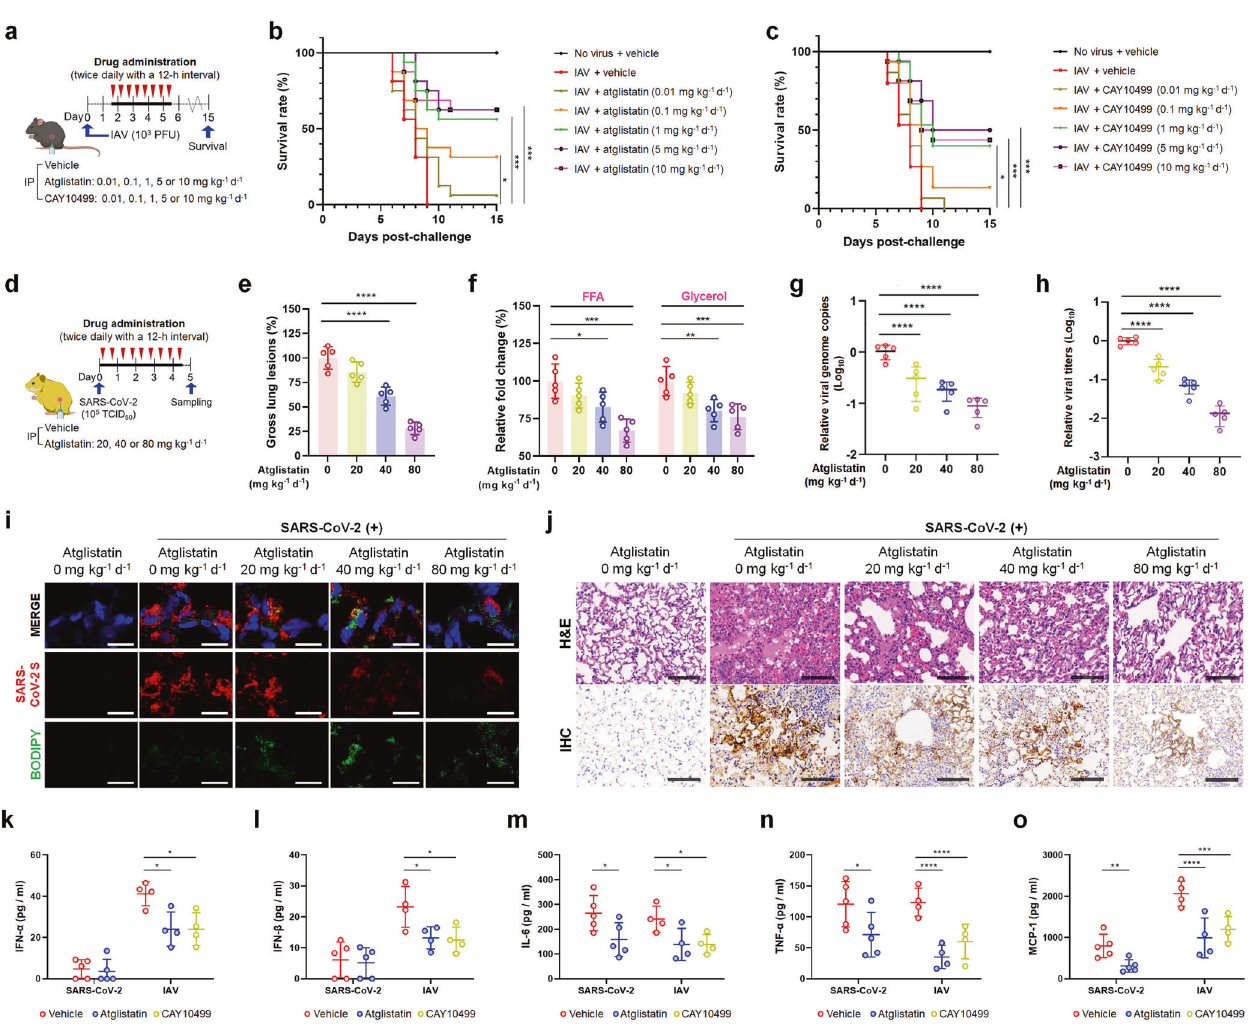
Fig. 5 In vivo antiviral and anti-proin fl ammatory cytokine effects of lipase inhibitors against in fl uenza A virus (IAV) and SARS-CoV-2. a Scheme of chemical administration twice daily for 4 consecutive days after challenge with 10 3 PFU of mouse-adapted IAV PR8 strain to mice ( n = 16). b , c Survival rates (expressed as percentages) of IAV-challenged mice by treatment with either atglistatin ( b ) or CAY10499 ( c ). d Scheme of chemical administration twice daily for 4.5 consecutive days after challenge with 10 5 TCID 50 of SARS-CoV-2 KCDC03 strain to Syrian hamsters ( n = 5). e Reduction in SARS-CoV-2-induced gross lung lesions in hamsters by treatment with atglistatin. f In vivo inhibition of FFA and glycerol release from LDs in lungs sampled from SARS-CoV-2-challenged hamsters ( n = 5) by treatment with atglistatin. g , h Reduction in SARS-CoV-2 genome copy number and infectious progeny production in lungs sampled from SARS-CoV-2-challenged hamsters ( n = 5) by treatment with atglistatin. i Representative images of LDs and virus replication. Retention of LDs (green, lower panels) and inhibition of SARS-CoV-2 replication (red, middle panels) in alveolar epithelial cells of lung tissues sampled from SARS-CoV-2-challenged hamsters by treatment with atglistatin. j Representative images of histological lung lesions. Amelioration of histological lung lesions (upper panels) and inhibition of SARS- CoV-2 replication (lower panels) by treatment with atglistatin. k – o The graphical representation of the IFN- α , IFN- β , IL-6, TNF- α , and MCP-1 levels in bronchoalveolar lavage fl uids (BALFs) sampled from SARS-CoV-2-challenged hamsters or IAV-challenged mice, which were vehicle- treated or treated with atglistatin or CAY10499. Each cytokine in BALFs was determined by ELISA assay as described in Supplementary Information. Results are presented as arithmetic means ± SD. * P < 0.05; ** P < 0.01; *** P < 0.001, **** P < 0.0001, one-way analysis of variance with Tukey ’ s correction for multiple comparisons. Scale bars = 30 µm for panel i and 200 µm for panel lung lesions at 80 mg kg − 1 d − 1 compared to lesions in the virus- challenged, vehicle-treated control group (Fig. 5d, e). In parallel, the treatment of IAV-challenged mice and SARS-CoV-2-challenged hamsters with these inhibitors resulted in a signi fi cant recovery of body weight and fewer clinical manifestations of disease compared to those of the virus-inoculated, vehicle-treated control groups (Supplementary Fig. 17). Consistent with in vitro data, FFA and glycerol levels were signi fi cantly reduced in the lung tissues of virus-challenged and drug-treated animals (Fig. 5f and Supple- mentary Fig. 18a, b), leading to the suppression of viral genome replication and infectious progeny production (Fig. 5g, h and Supplementary Fig. 18c, d). The interruption of virus-induced LD lesions in a dose-dependent manner, showing a 72% reduction in